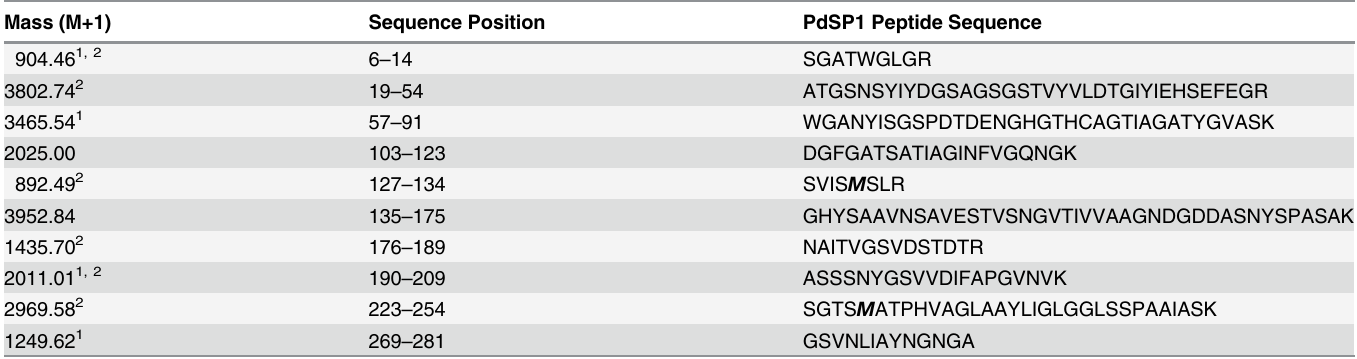
Table 3. Tryptic peptide ion masses, position corresponding to the mature protein, and the corresponding amino acid sequences translated (GenBank ELR07576.1) from the P . destructans gene matched to PdSP1 (27.9 kDa protein). Mass (M+1)